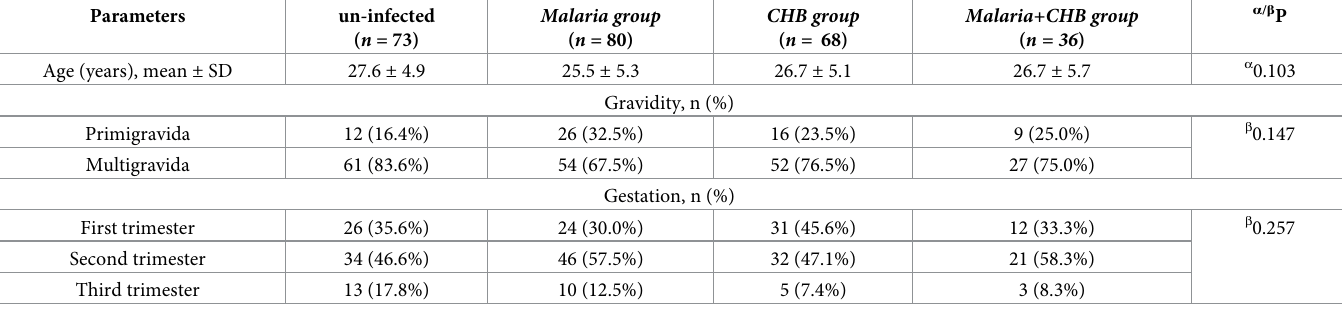
Table 1. Distribution of demographic and obstetric characteristics in the different groups of pregnant women.